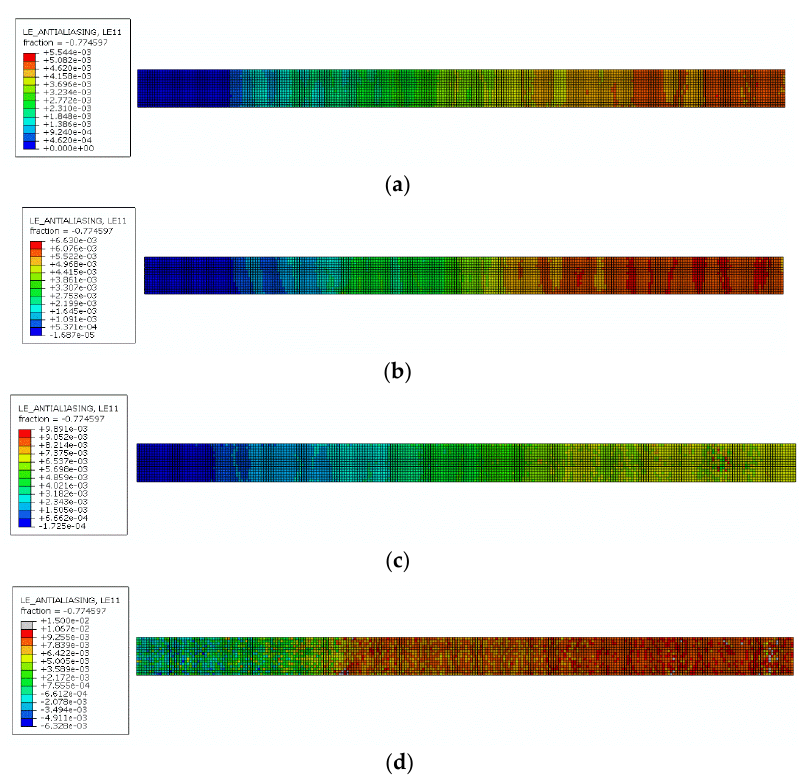
Figure 9. Numerical UHTSS strains at failure: ( a ) Beam G1; ( b ) Beam G1-U; ( c ) Beam P1; ( d ) Beam P1-U.